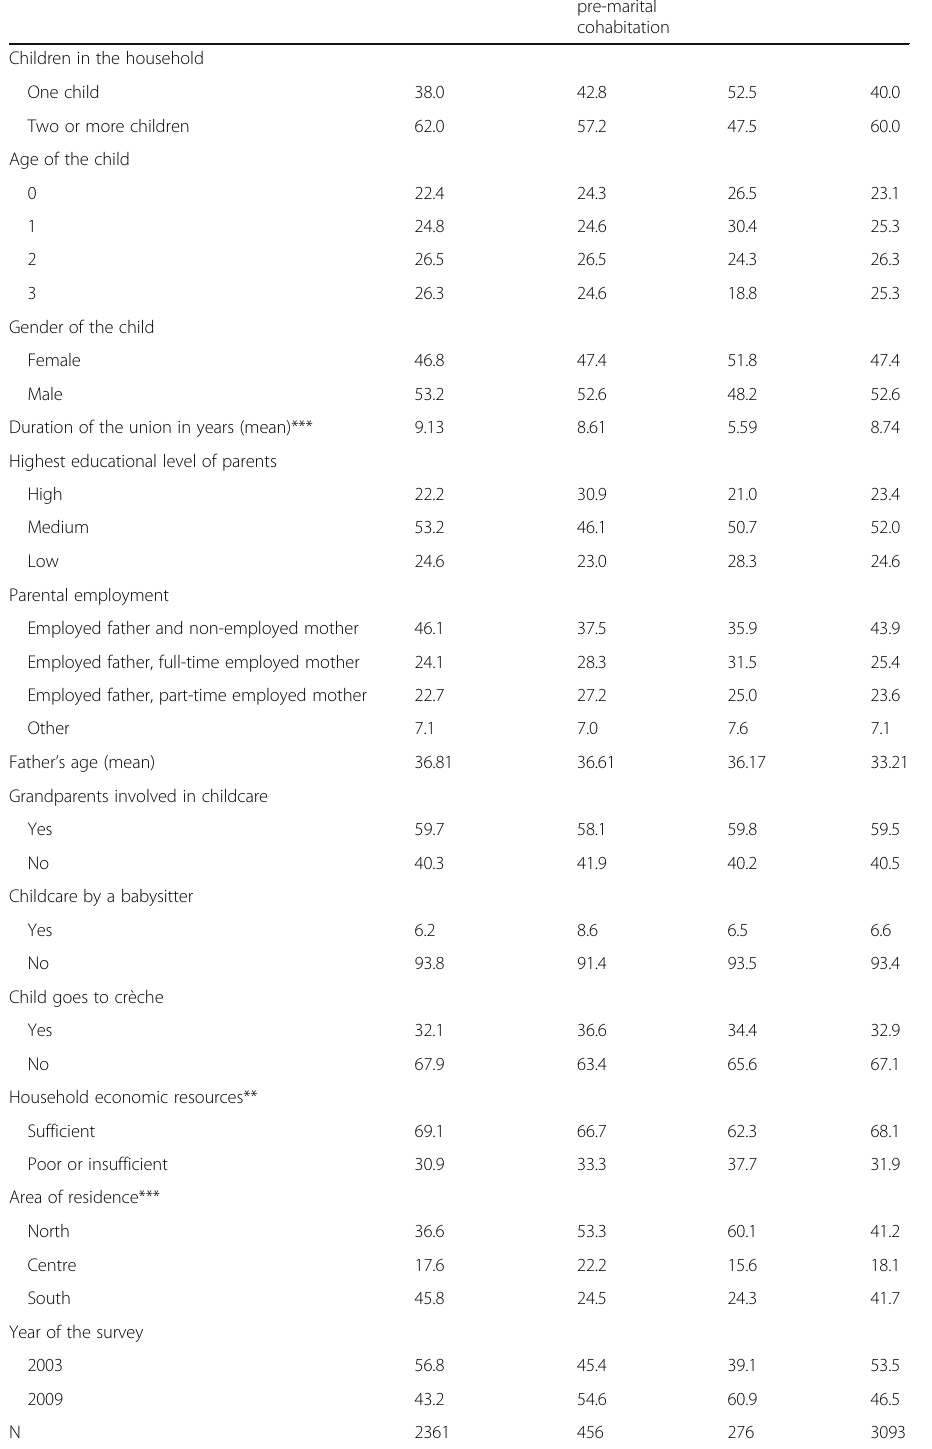
Table 1 Sample characteristics (percentages or means) according to the type of couple